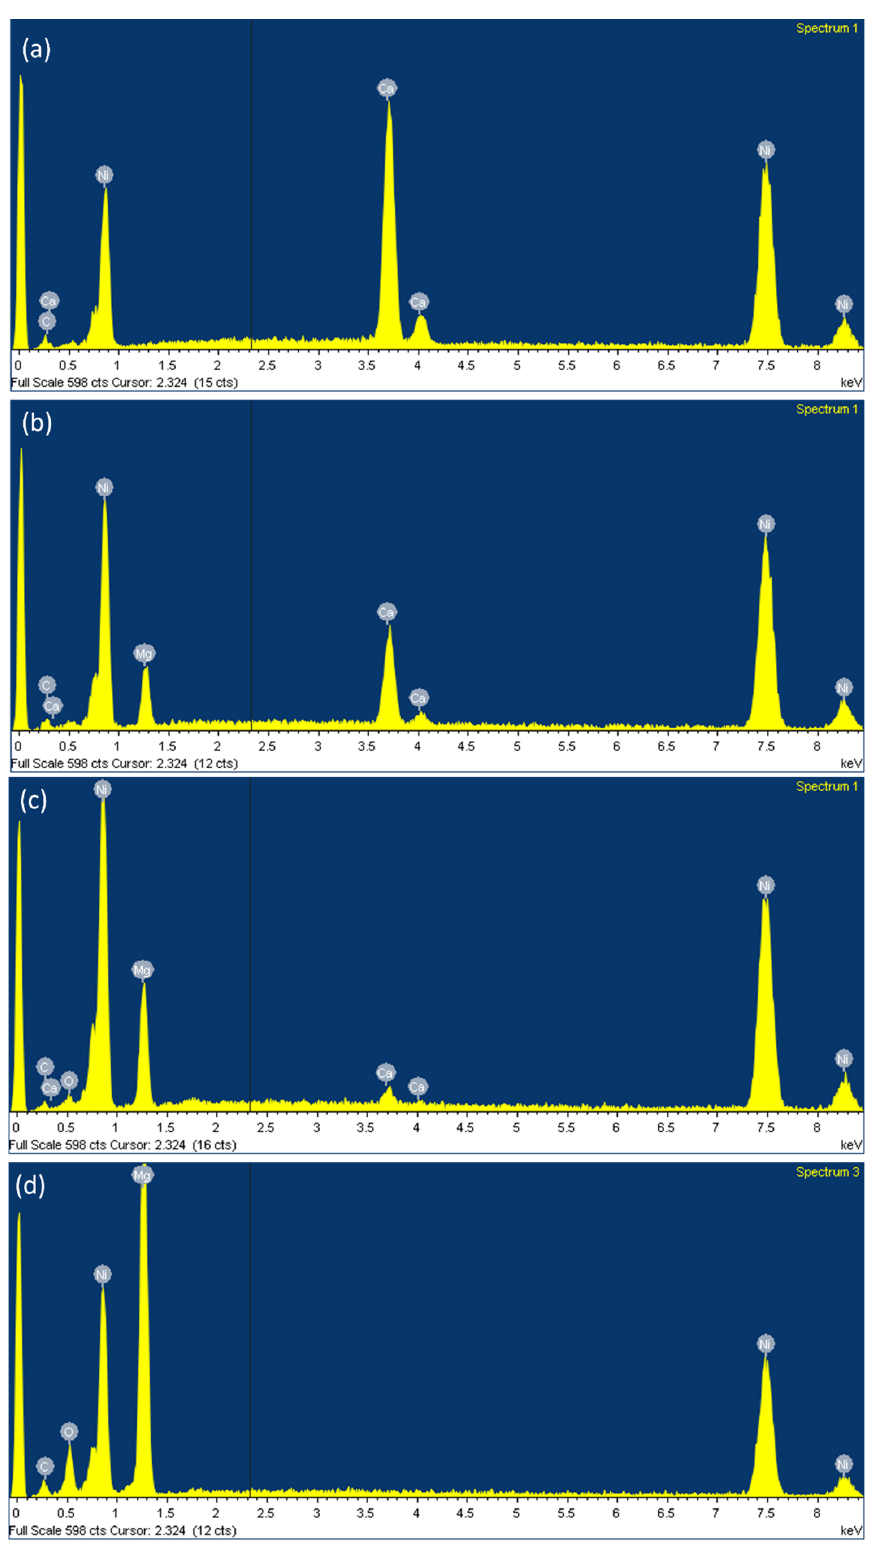
Figure 8. EDS spectra of the ( a ) CaNi 2 ( b ) Ca x Mg 1 − x Ni 2 ( x = 0.5) ( c ) Ca x Mg 1 − x Ni 2 ( x = 0.33) ( d ) MgNi 2 .